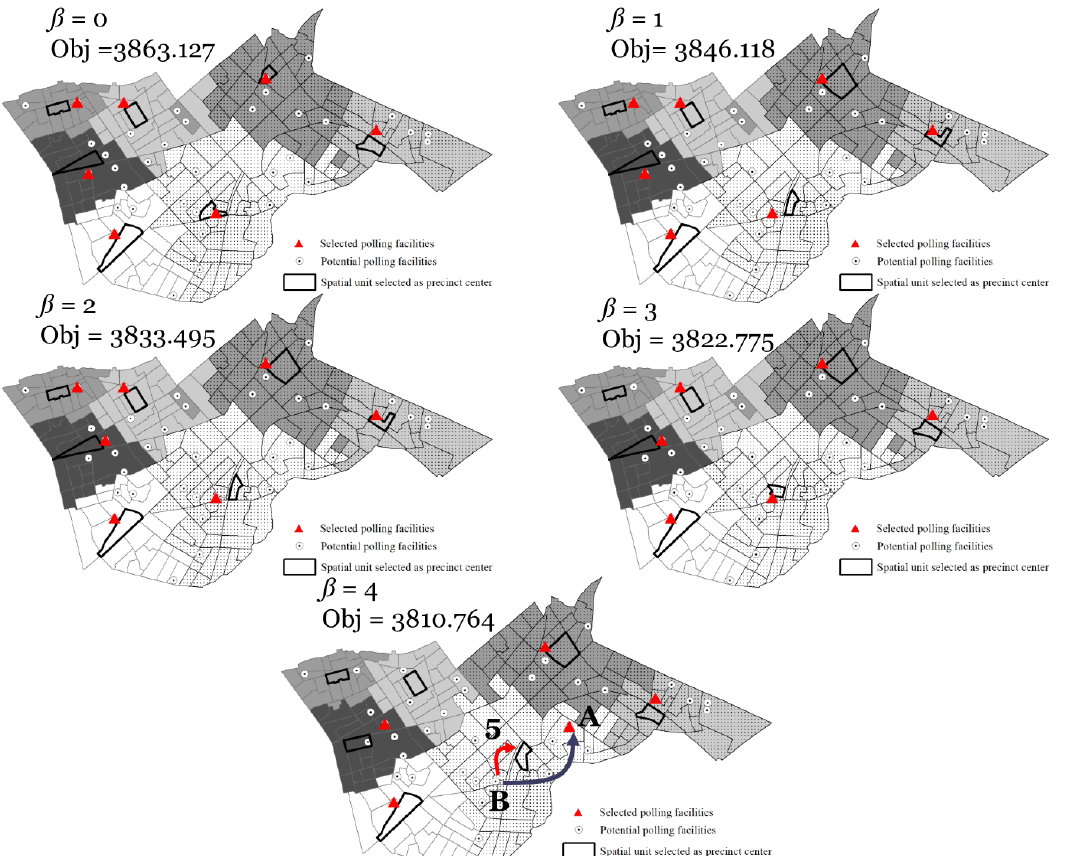
Figure 6. Delineated precincts when C min = 3000.